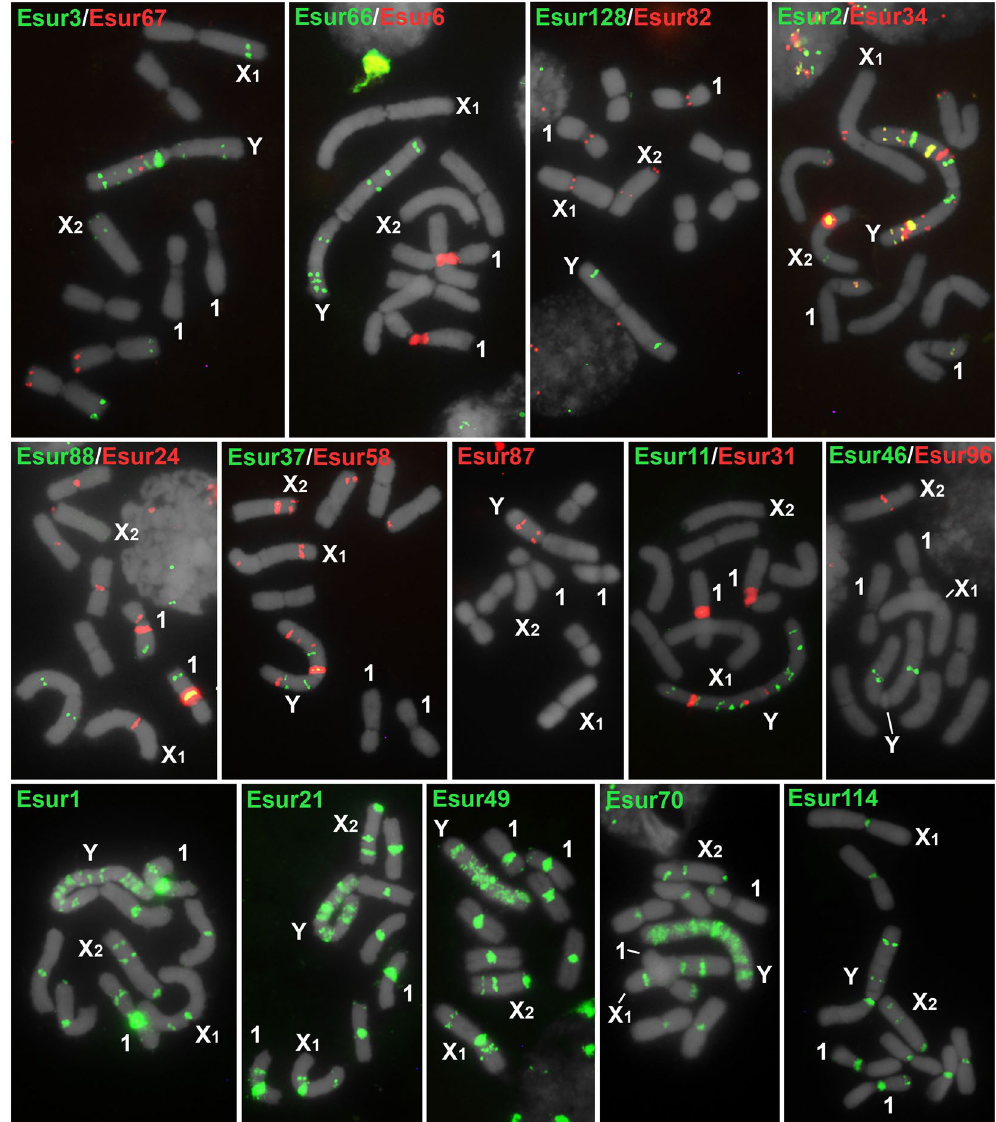
Figure 2. Chromosomal location of 22 satDNAs in mitotic chromosomes of male embryos of E . surinamensis by FISH. Upper and middle panels show satDNAs with monomers > 60 bp, lower panels satDNAs with monomers < 60 bp. The satDNA family names and hybridization signals for each type of the probe are shown in the images by colors. Note the enrichment in the neo-Y (Y) sex chromosome with multiple loci or spread signals for some repeats, while the X 1 and X 2 sex chromosomes show only a few or even none hybridization